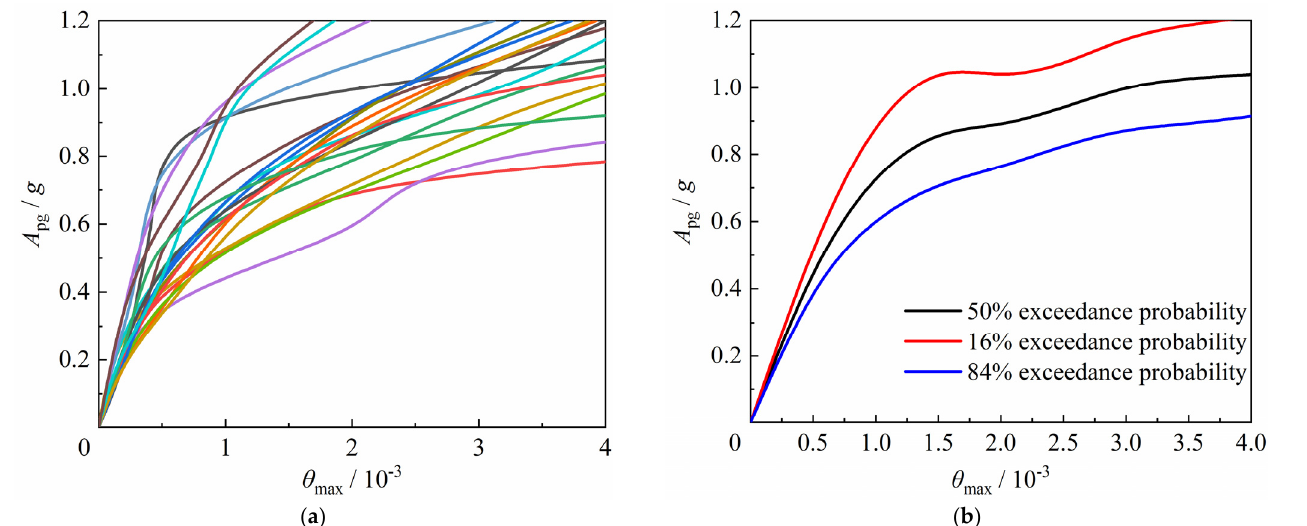
Figure 11. IDA curves under earthquake: ( a ) IDA curves under 20 ground motion records; ( b ) 16%, 50%, and 84% exceedance probability curves.